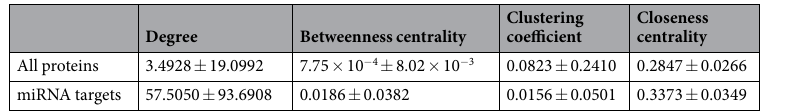
Table 2. Topological parameters of all nodes and miRNA targets in